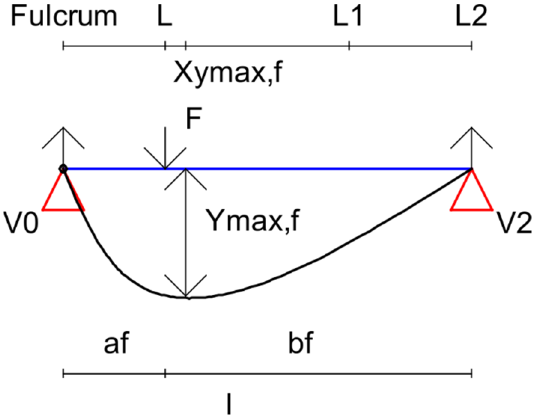
Figure A4. Representation of the hyperstatic beam without the constrain L1 .